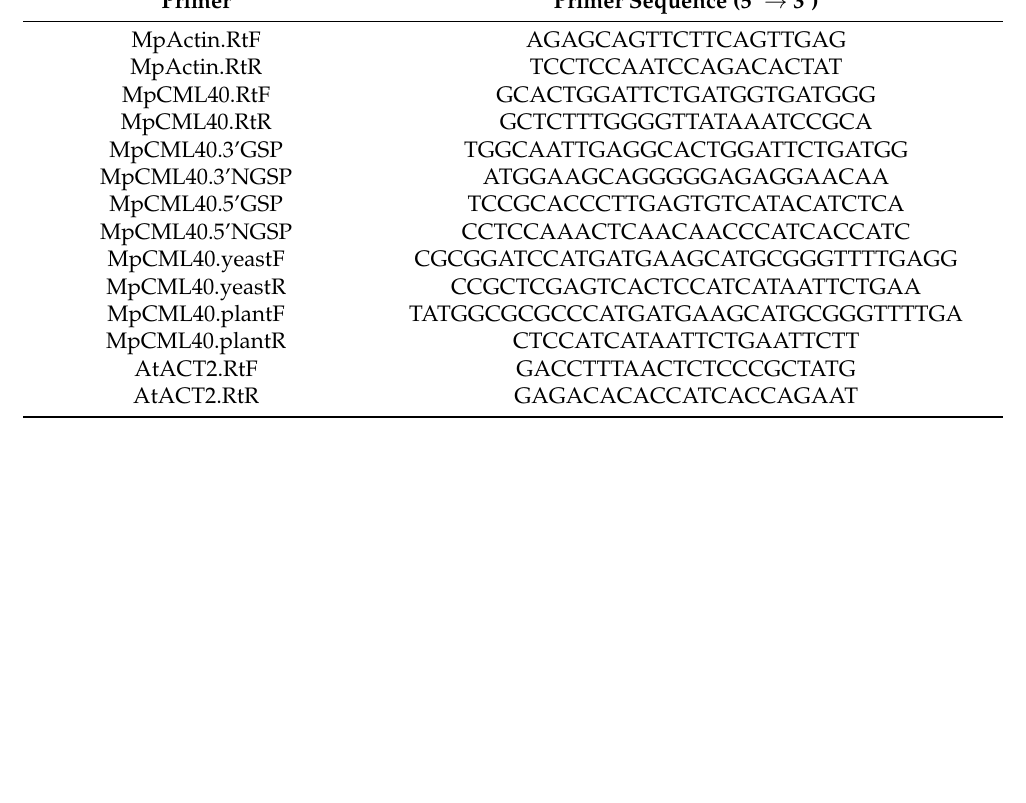
Figure 4. Gene expression changes of MpCML40 in Pongamia roots and leaves upon salt stress. Relative expression levels of the MpCML40 gene in roots ( A ) and leaves ( B ) after 500 mM NaCl treatment were analyzed by qRT-PCR using primers